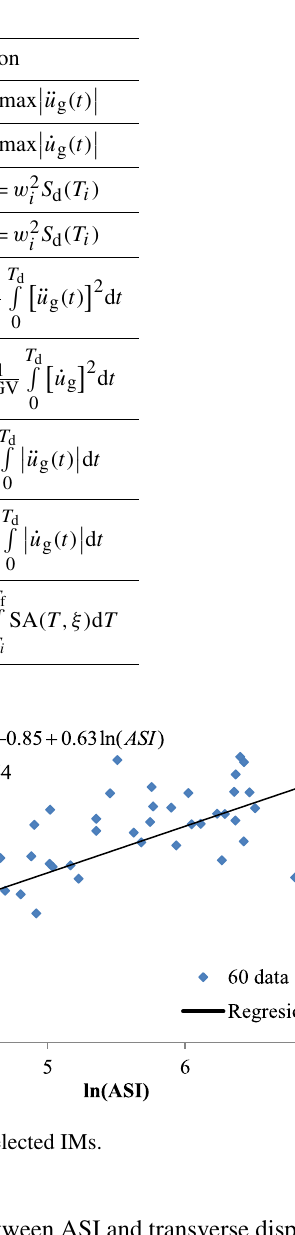
Table 1. Intensity measures (IMs).